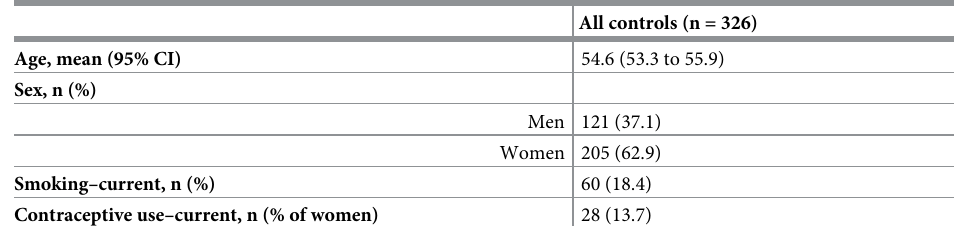
Table 1. Demography of included control subjects of THE VTE study.